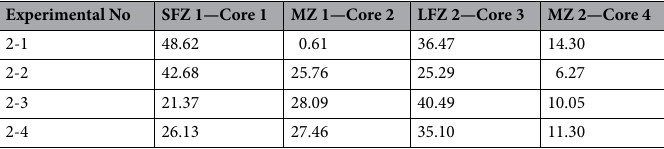
Table 8. Percentage of residual reserves in different zones at the end of Group II